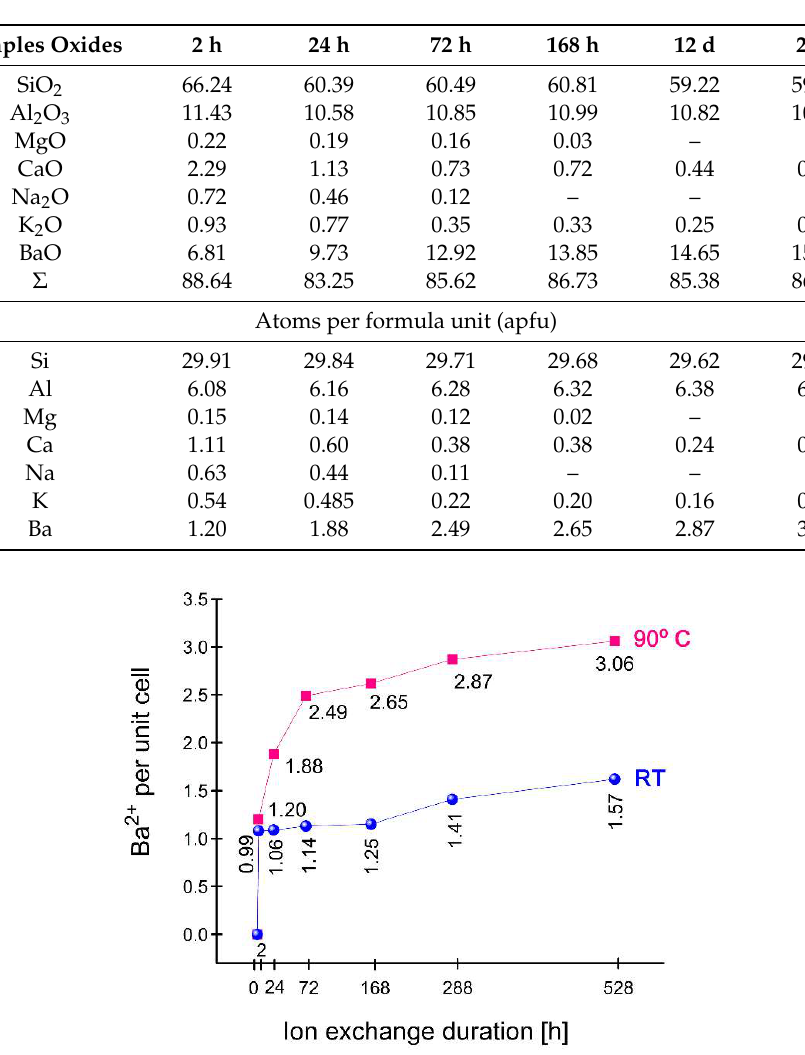
+ for di ff erent duration time and temperature (EDS Figure 3. Exchanged Ba 2+ for different duration time and temperature (EDS data). Figure 3. Exchanged Ba 2